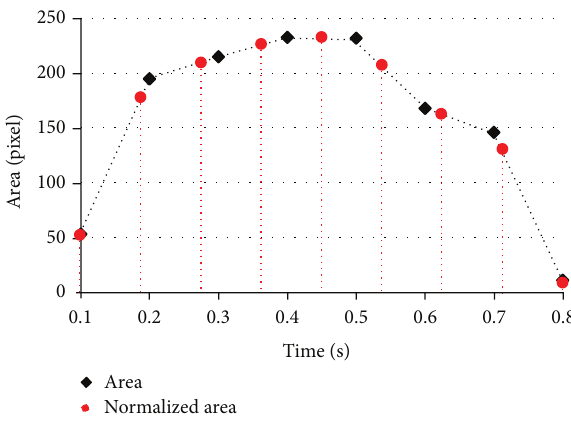
Figure 11: Example of nine normalize areas.